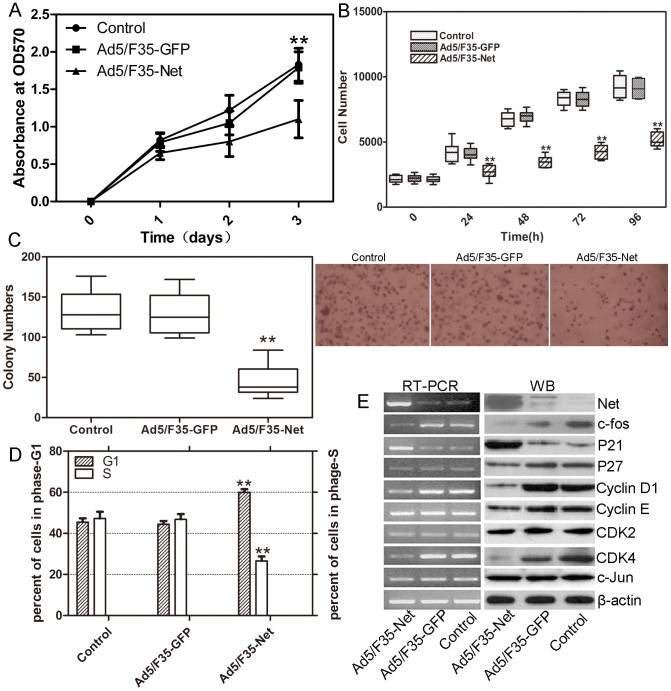
Net inhibited growth and proliferation in pancreatic ductal adenocarcinoma cell PL45.(A) Growth of PL45 cells transfected with or without Ad5/F35-Net was measured by MTT assay. (B)The growth curve of PL45 cells transfected with or without Ad5/F35-Net was obtained by counting cell numbers per well on each day. (C) Colony formation assay was performed using PL45 cells transfected with or without Ad5/F35-Net after 48 h. (D) Cell cycle of PL45 cells transfected with or without Ad5/F35-Net was evaluated. (E) Cell cycle related genes were examined at mRNA and protein levels 48 hours after Ad5/F35-Net transfection. *p<0.05, **p<0.01.